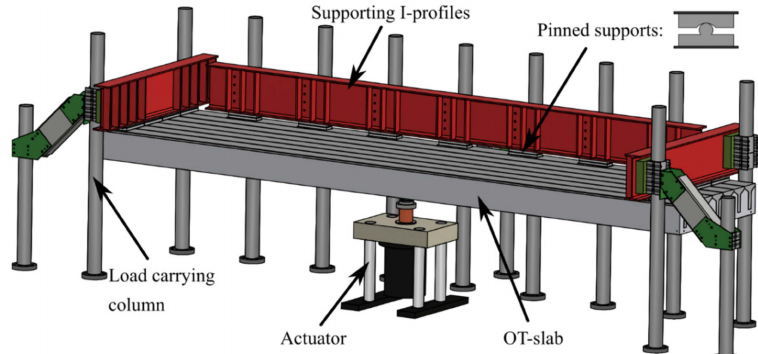
Figure 3. Large-scale OT-slab experimental setup.